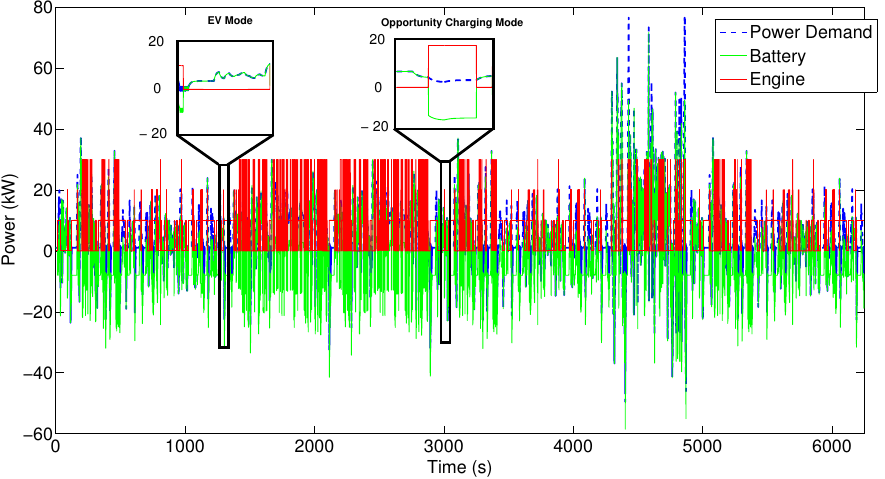
Figure 13. Power distribution in the SHEV during the combined driving cycle (EMC: 3-mode